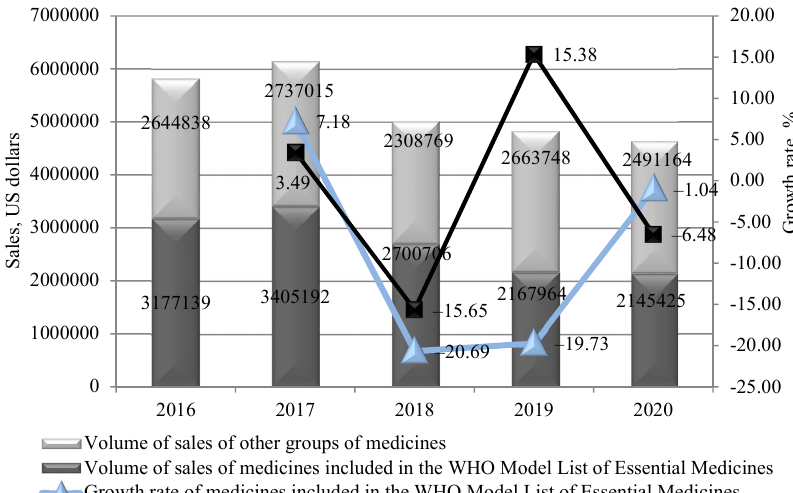
3177139 3405192